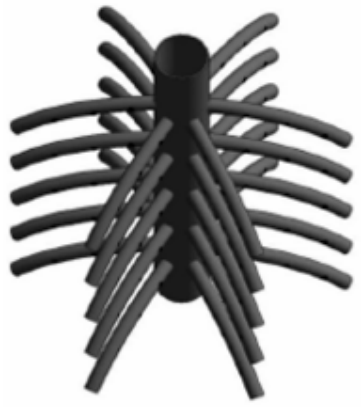
Figure 6. New type of dehydration pipe.